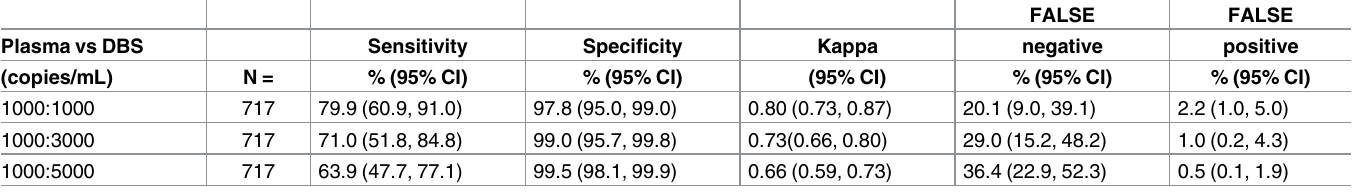
Table 2. Sensitivity, specificity, Kappa agreement, and false negativity and positivity of one Abbott DBS VL sample compared with the paired Roche plasma VL among children on ART in Mozambique.